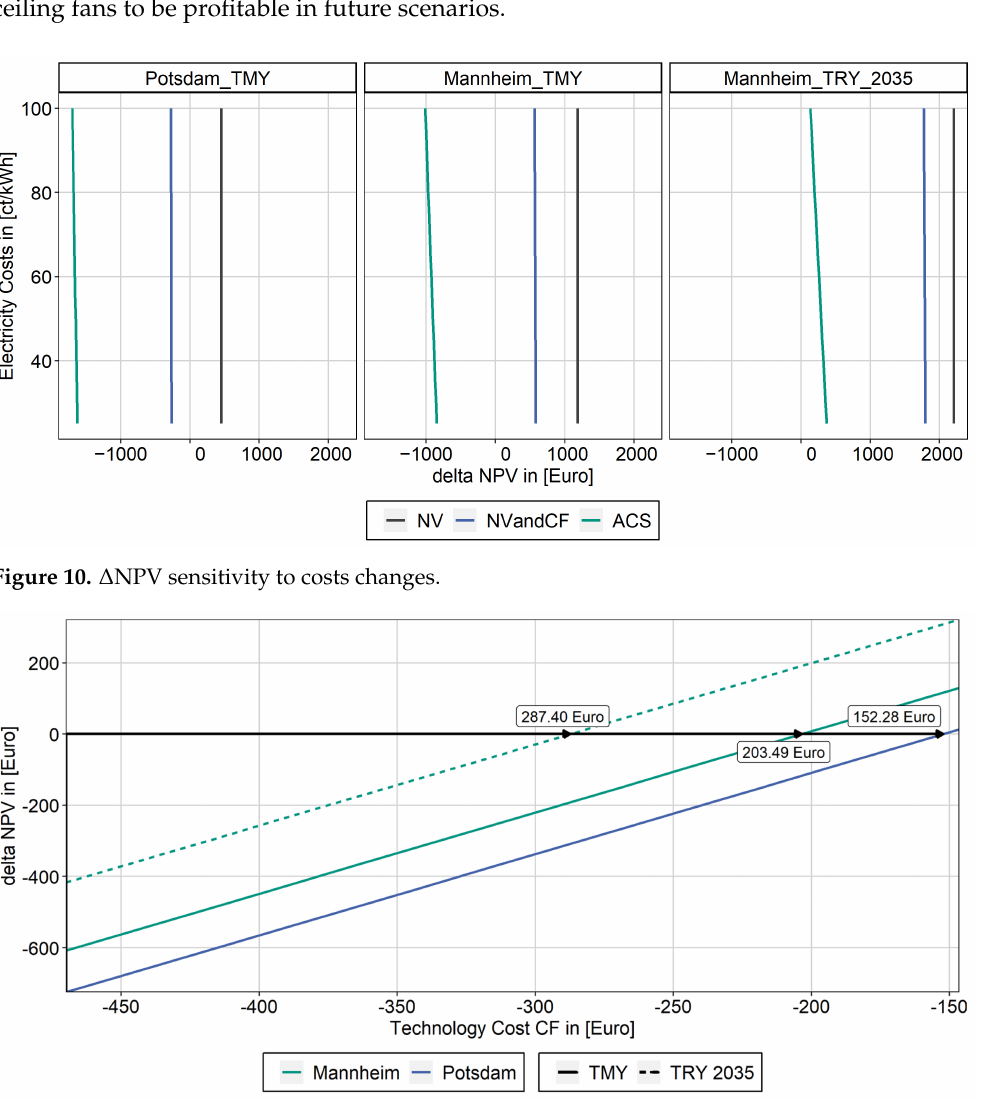
Figure 11. ∆ NPV of the ceiling fan strategy against night ventilation for the three representative locations and climatic